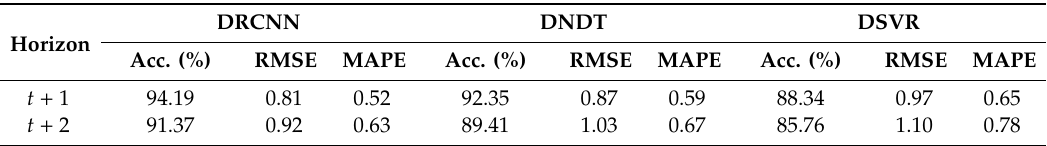
Table 5. Multiple-step ahead forecasts in forecast horizon = t + 1 and t + 2.